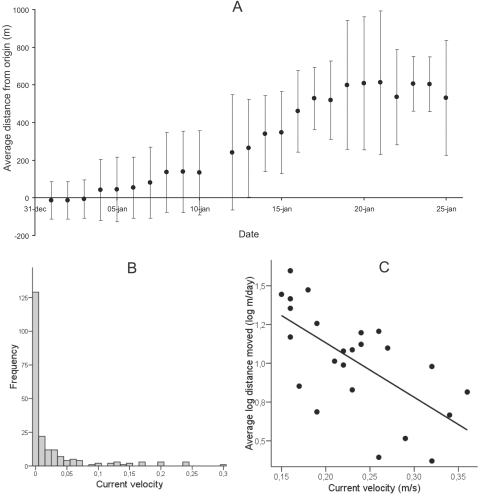
Behaviour of roach during migration.(A) Net upstream distance from first recorded position during the investigation. Error bars indicate SD. (B) Frequency distribution of current velocities at the positions of individual roach in the stream. (C) Average movement undertaken per day by roach as a function of water velocity. Note logarithmic scale on Y-axis.